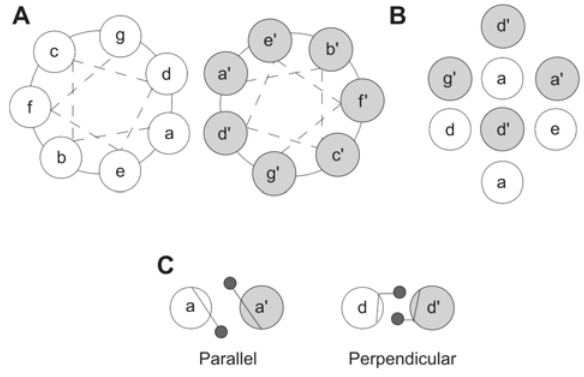
Figure 2 Schematic representation of a two-stranded canonical coiled coil. (A) Helical wheel diagram showing the arrangement of residues along the superhelical axis with a straightened interhelical interface to emphasize the heptad repeat structure. (B) Knobs-into-holes packing of the side chains in the a and d positions. The a and d side chains in the middle are knobs fitting into a hole defined by four residues on the other helix (residues with the same notation are one heptad apart). At the same time, they also participate in hole formation for knobs on the interacting chain. (C) Organization of interaction layers in the hydrophobic core of coiled